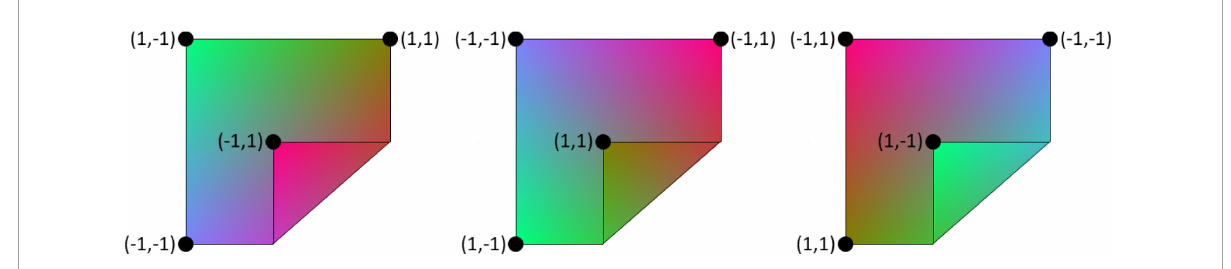
FIGURE5 Equivalent mesh representations of a cloth shape. Geodesic (uv) coordinates are shown for the cloth corners and a gradient texture is added to visualise geodesic coordinates over the cloth surface. The representations differ in how they map geodesic space to Cartesian space, but represent the same shape. For every possible shape configuration of a square cloth, there are eight equivalent mesh representations.